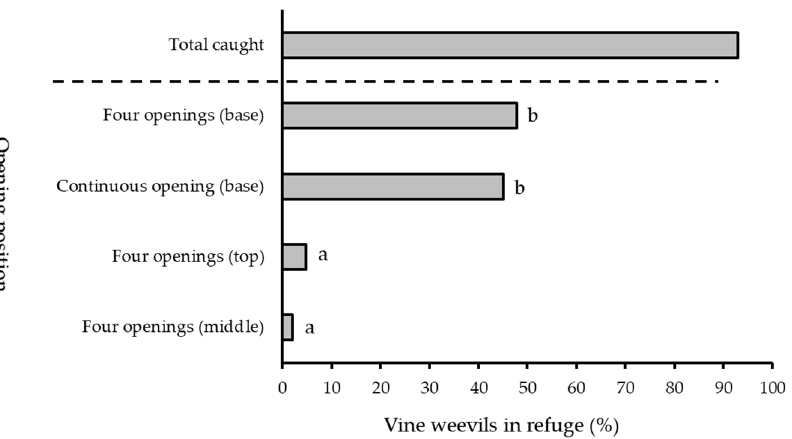
Figure 6. Percentage of vine weevil adults recorded in refuges with openings on the side, top or base—continuous opening or four openings—when released as a group of ten individuals ( number of replicate days = 5). Different letters denote significant differences between means ( p < 0.05).